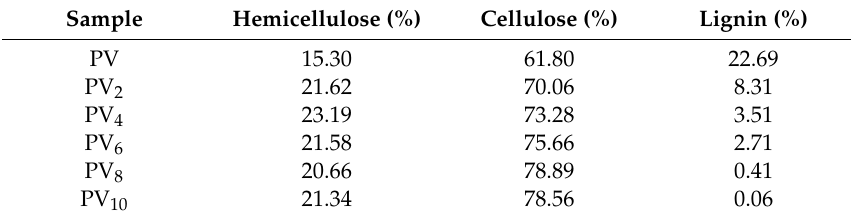
delignification Table 1. The relative content of cellulose, hemicellulose, and lignin of all PVs with different delignification time.